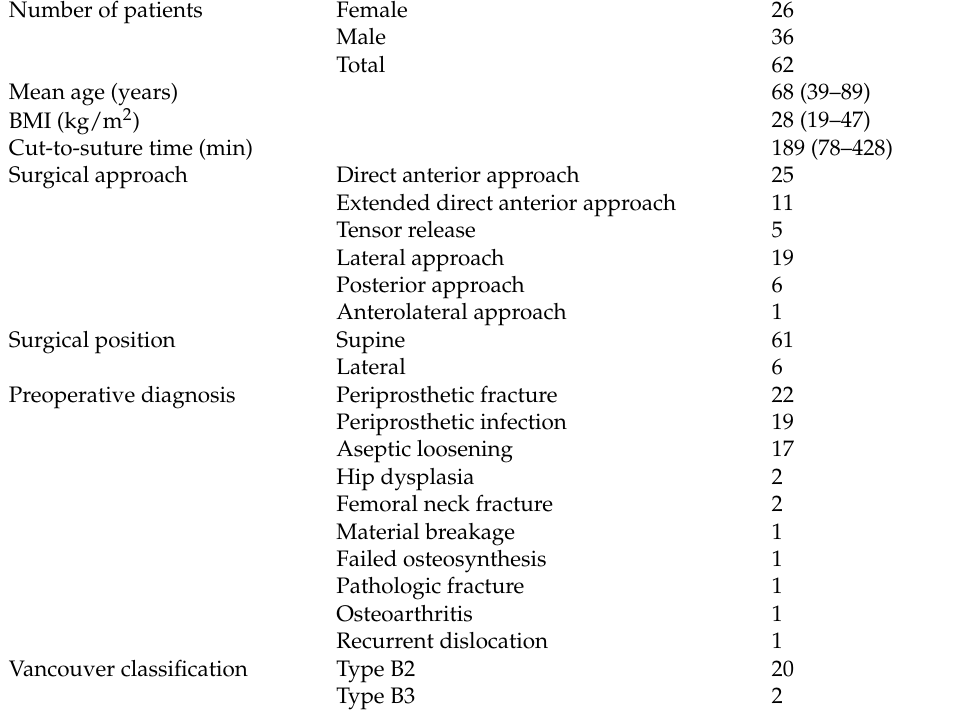
Table 1. Patients demographics of the study group. Range is given in